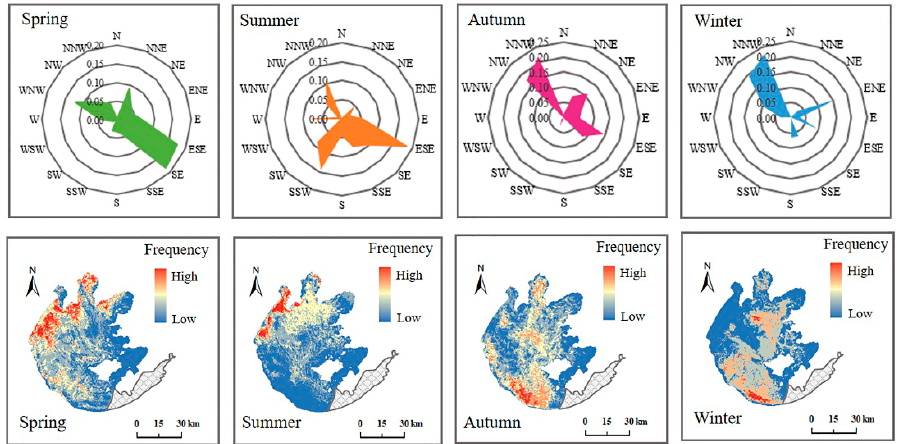
Figure 12. The wind direction rose charts and the spatial distributions of algal bloom frequency in the four seasons of 2017 for Taihu Lake.